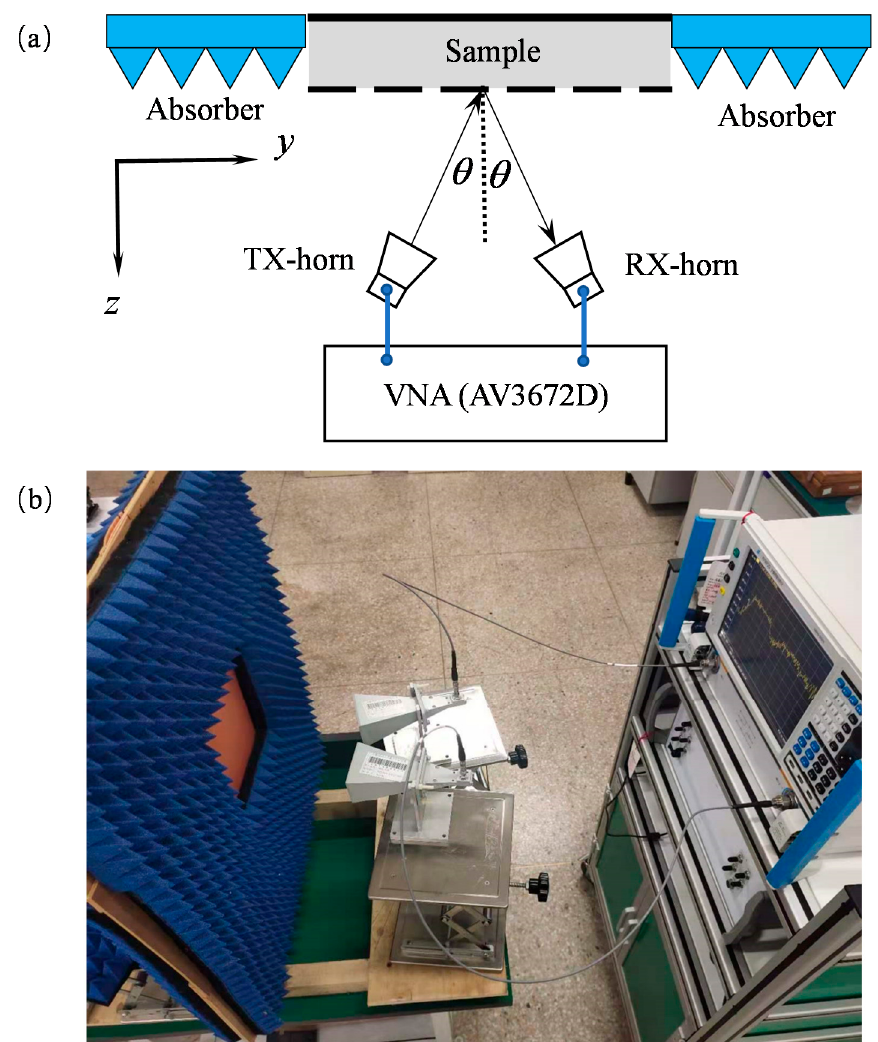
Figure 7. The measurement setup. ( a ) Schematic diagram using bistatic method; ( b ) instrumentation based on VNA technology.